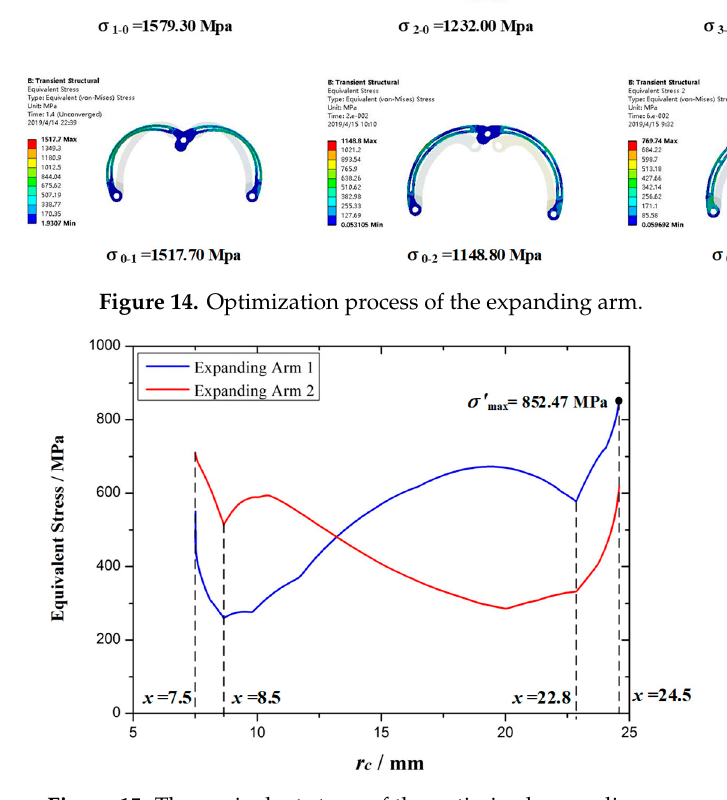
Figure 15. The equivalent stress of the optimized expanding arm.